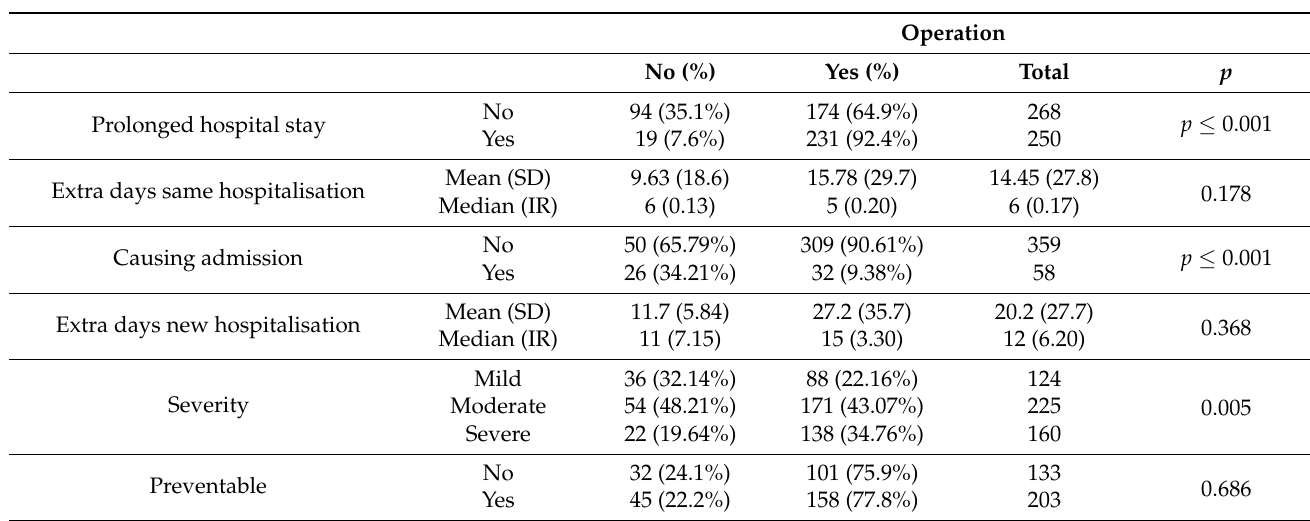
Table 4. Impact of AEs.